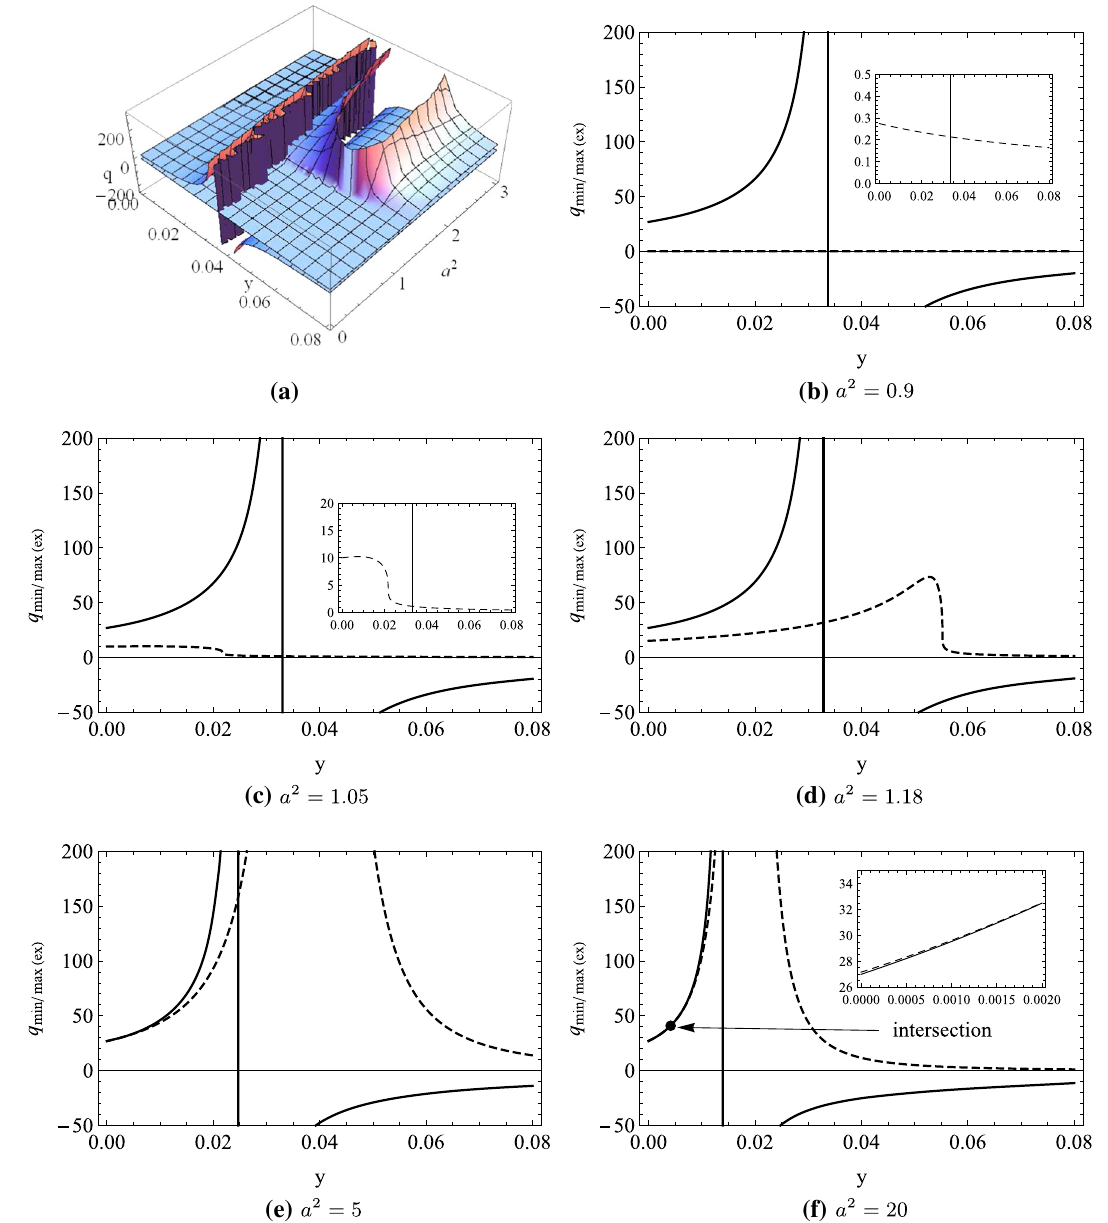
Fig. 9 3D plot of functions q ( y , a 2 ) ( a ) and its a 2 = const.- slices corresponding to values between outstanding limits a 2 = = 1 . 08316 , a 2 = 1 . 21202 and a 2 = 1 , a 2 ( ex ( ex ) - ex ( ex ) + ) min crit rrb ( max ) 9 . The positive branch of the full curve is the graph of the func- tion q max ( ex ) ( y , a 2 ), its asymptote intersects the a 2 – y plane in the curve y max ( d ) ( a 2 ). The dashed curve in b describes the local maxima q max ( ex + ) ( y , a 2 ) under the inner horizon. In c , d it represents local